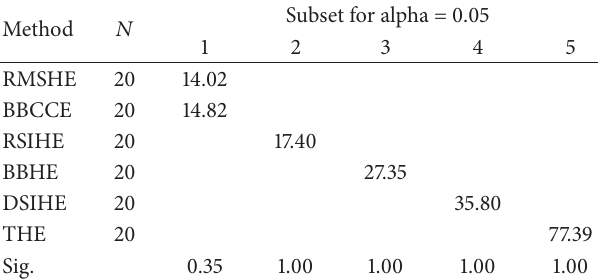
Table 6: Categorization of contrast enhancement methods into homogenous subset using the Duncan test for